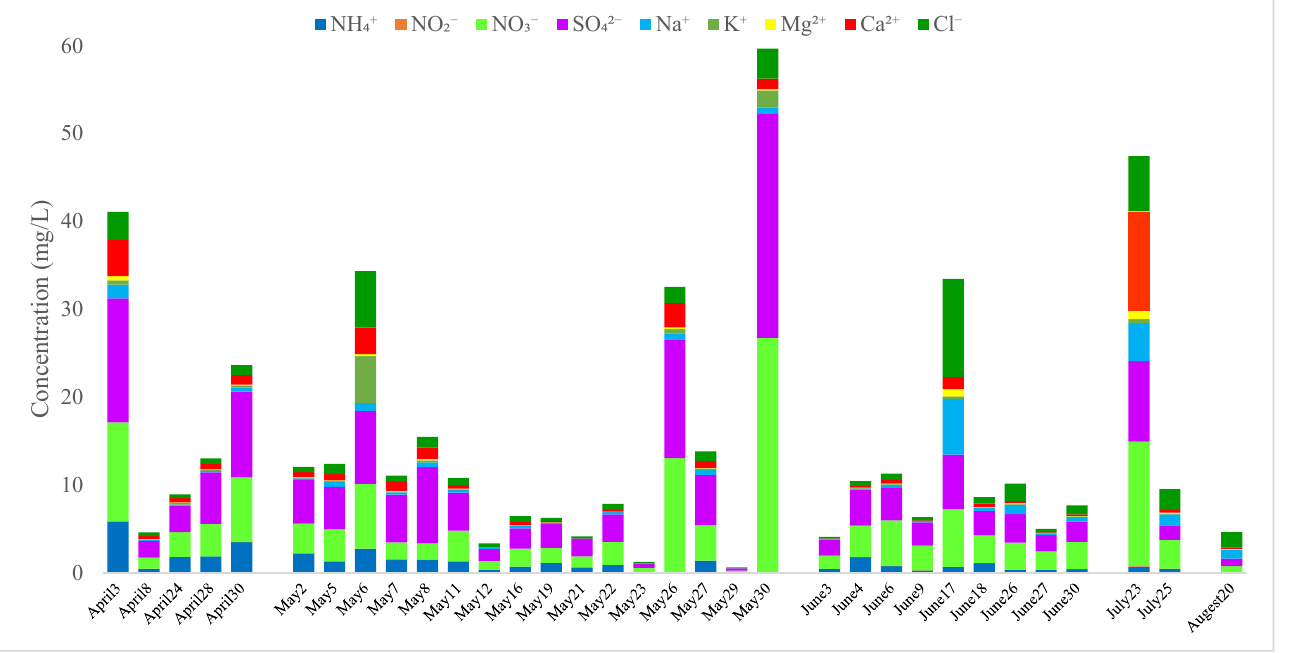
Figure 3. The water-soluble ions in sample .